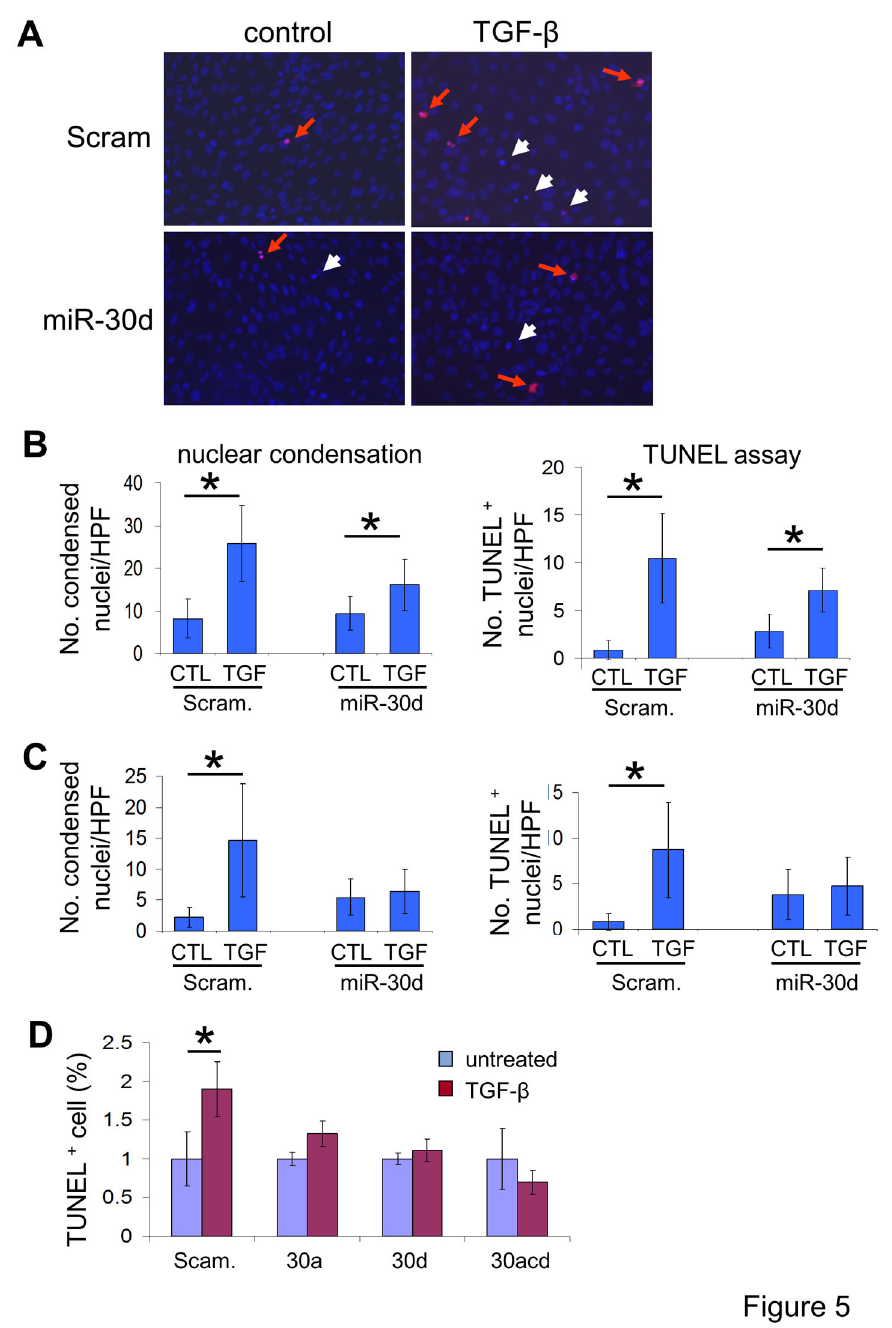
Figure 5. Lentiviral expression of miR-30s prevents TGF-β-induced apoptosis in podocytes. A . Representative images showing TUNEL-positive nuclei (red arrows) and condensed nuclei (white arrows) in conditionally immortalized murine podocytes expressing scrambled miR (Scram) or miR-30d left untreated or treated with TGF-β for 48 hr (20X). B . and C. Bar graphs showing the mean ± S.D. of the condensed nuclei or TUNEL-positive nuclei per high power field (HPF, 20X) in the experiments described in A. Fifty HPFs were examined for each sample (bar). B. Quantitation of apoptosis rates under permissive proliferating culture conditions (33 °C, + IFN-γ). C. Quantitation of apoptosis rates under non-permissive differentiating culture conditions (37 °C, - IFN- γ); D. Bar graph demonstrating the fraction of TUNEL-positive nuclei in human podocytes infected with lentiviral vectors to express either scrambled control miR (Scram) or miR-30a (30a), miR-30d (30d), or combined miR-30a, -30c, -30d (30acd) left untreated (blue bars) or treated with TGF-β (5 ng/ml) for 48 hr (red bars). * denotes p < 0.05.